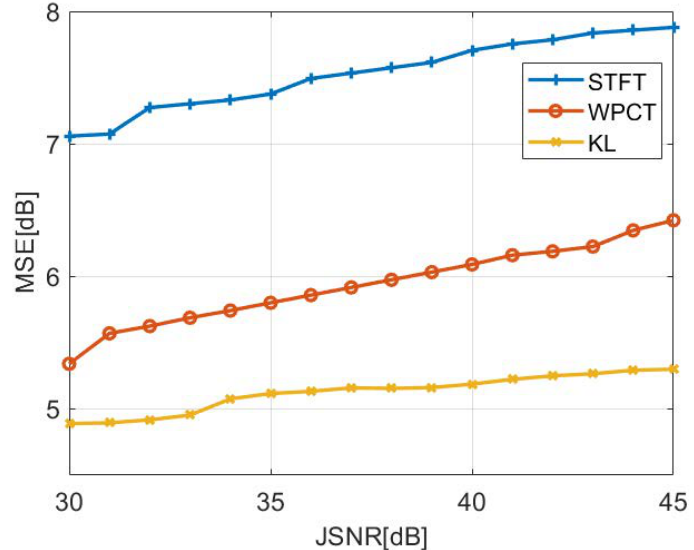
Figure 13. MSE of different interference mitigation algorithms under chrip signal